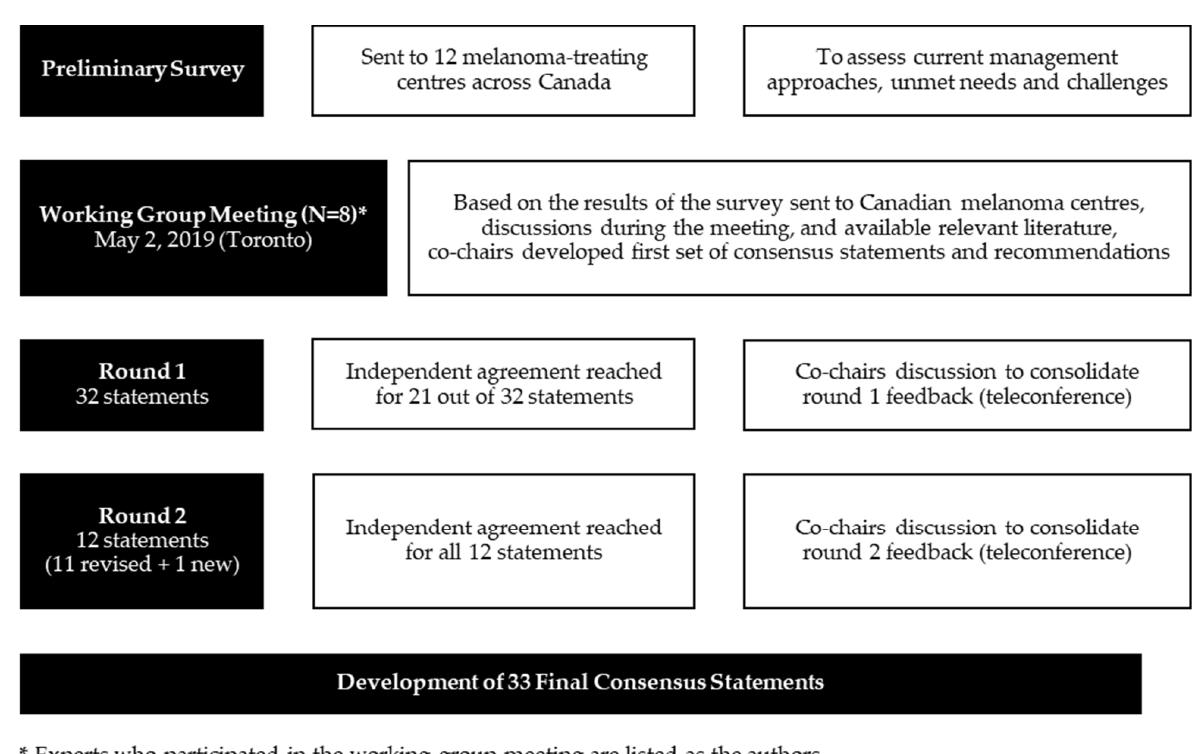
Figure 1. Modified Delphi Consensus Method to Develop Consensus Statements for the Management of Dabrafenib and Trametinib-related Pyrexia Syndrome in Canadian Daily Practice.